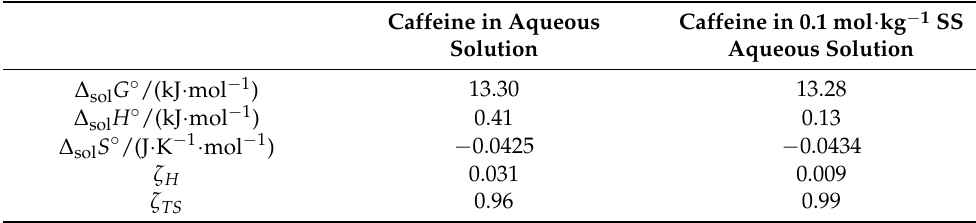
Table 2. The obtained apparent thermodynamic values of ∆ sol G ◦ , ∆ sol H ◦ , and ∆ sol S ◦ , as well as ζ H and ζ TS for caffeine in water and SS aqueous